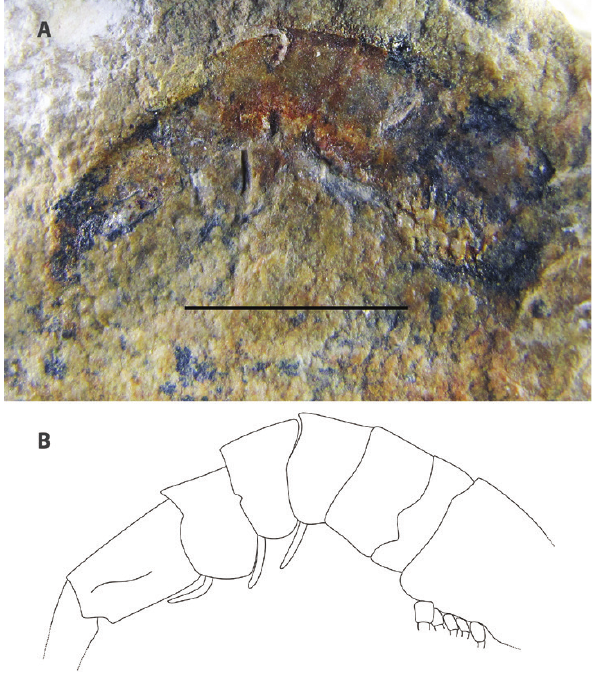
Figure 4 - Araripenaeus timidus n. gen. n. sp. (MCNHBJ 339). A, lateral view of the holotype. B, line drawing of the holotype. Scale bar: 5